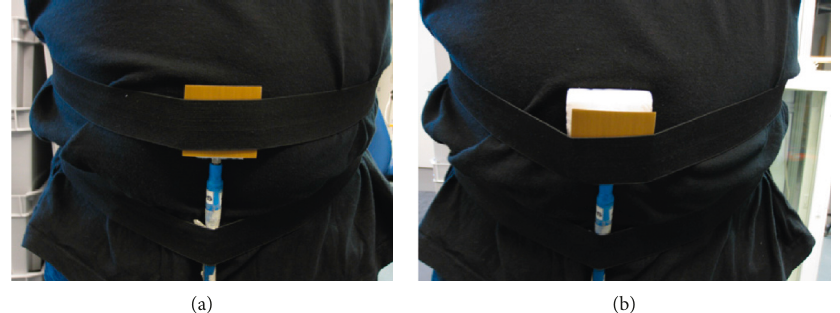
Figure 19: On-body measurements using the reflector-backed antenna for (a) d � 0 mm and (b) different separation distances using Rohacell pieces of different thicknesses.